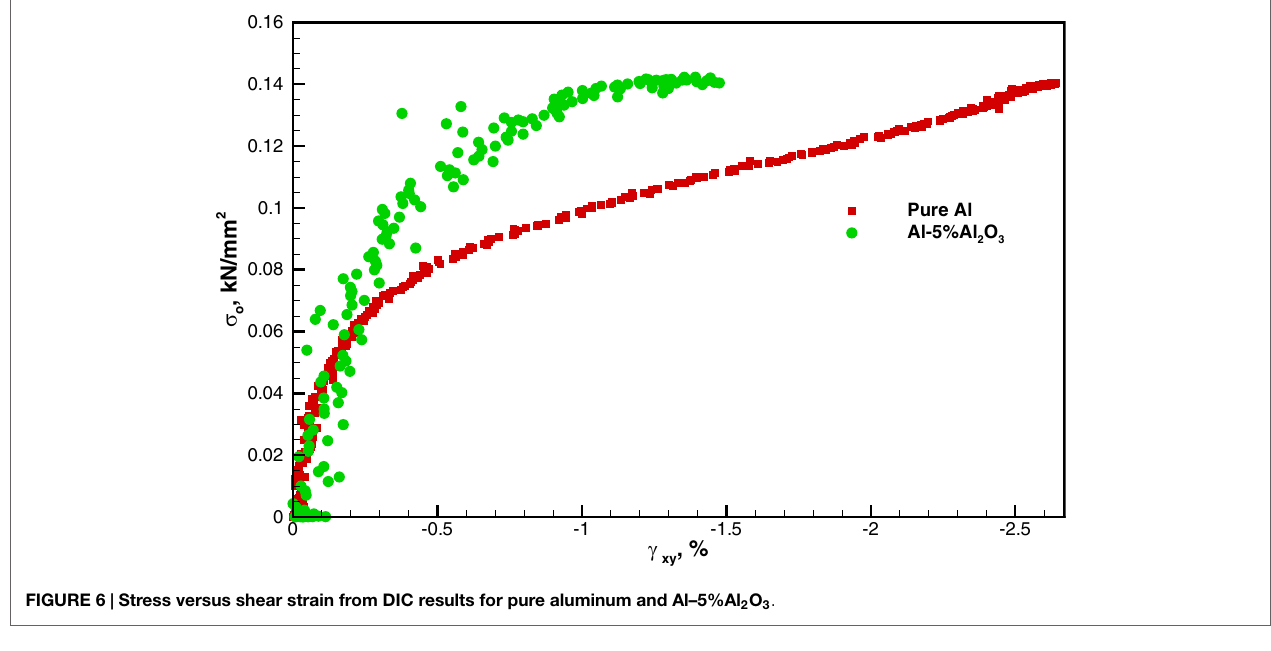
FIGURE 6 | Stress versus shear strain from DIC results for pure aluminum and Al–5%Al 2 O 3 .